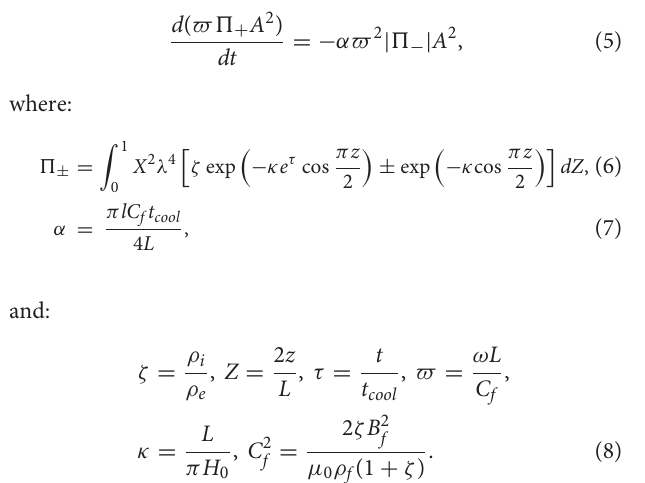
FIGURE 6 | The absolute value of the displacement of the Gaussian fitted position profile (blue line from Figure 4 ) from the background 8 th order polynomial trend (green line from Figure 4 ) through time. The cut-out in the top right corner provides a magnified view of the region on the graph bounded by the black dashed box. This cut-out clearly shows the deviation of the damping profile from a typical Gaussian or exponential fit during this time due to a slight increase in the measured amplitude (compared to the background trend). Similar results are found for other background polynomial trends.